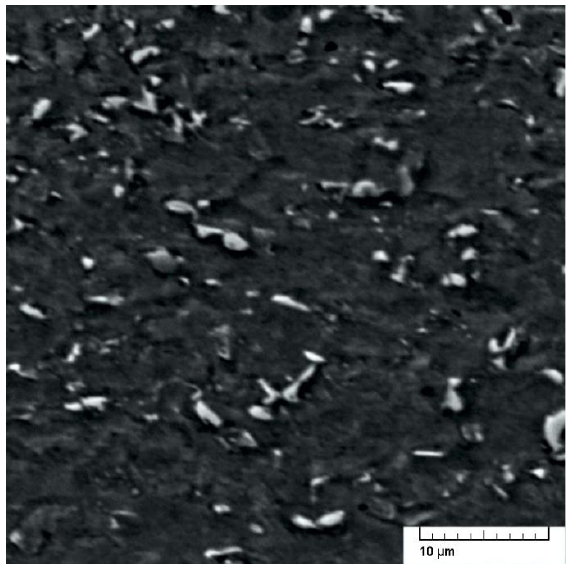
Figure 5. The initial structure of the 1.0939/HCT500X DP steel.